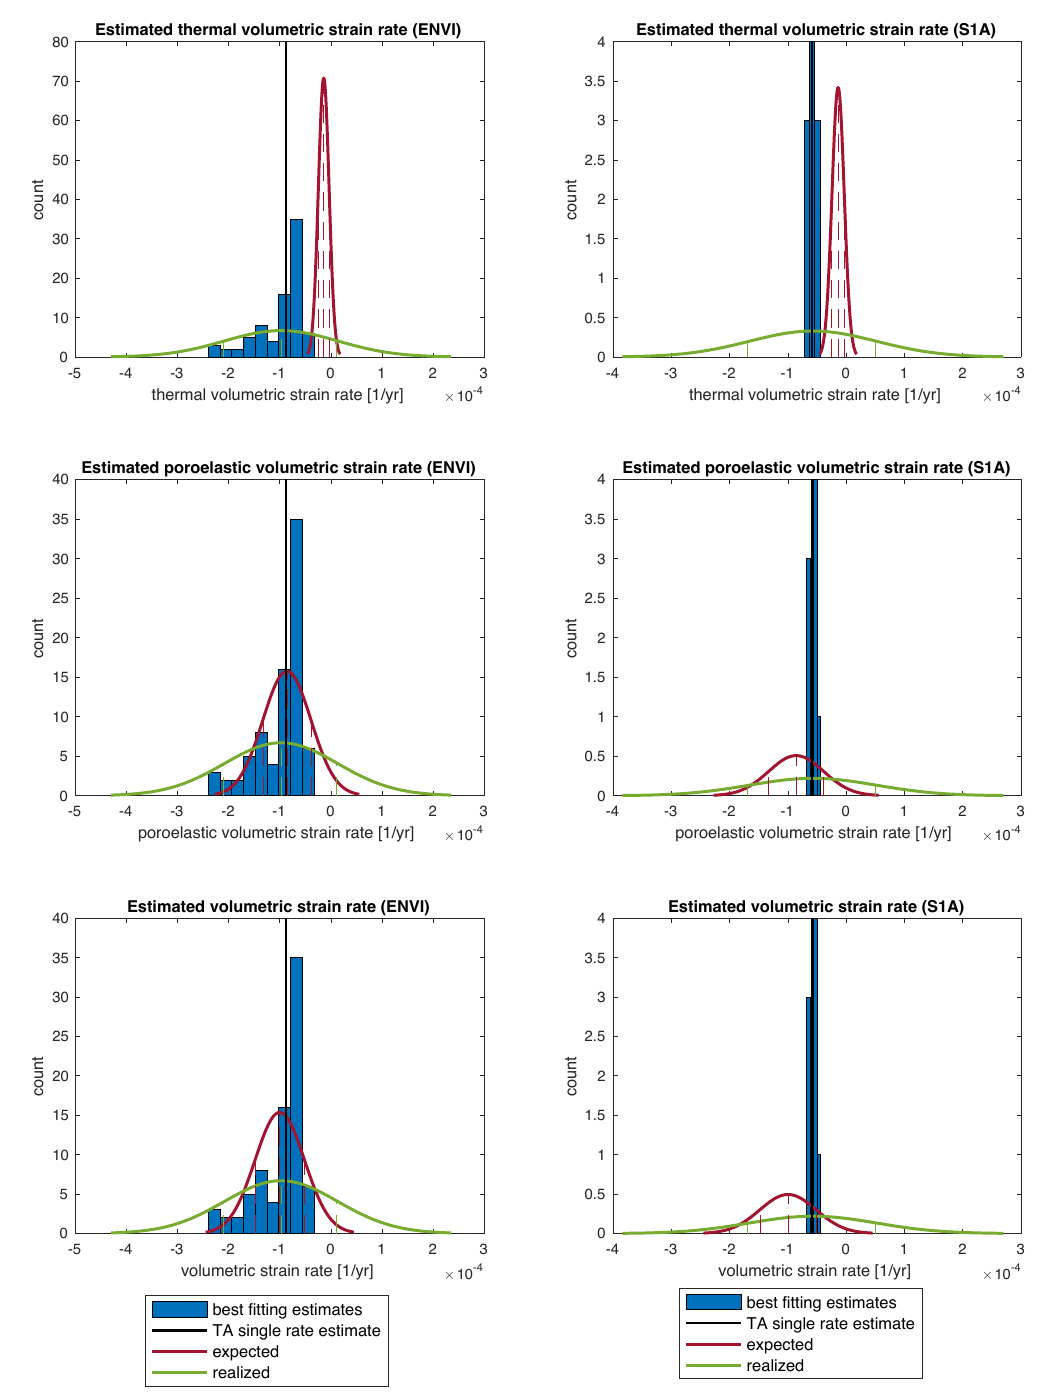
Figure 14. Histograms of best-fitting estimates of volumetric strain rates interpreted in terms of thermal contraction of the rock matrix (first row), a decrease in pore-fluid pressure (second row), and a linear combination of the two (third row) for Envisat pairs corresponding to the time interval from 2004 to mid-2010 (first column) and Sentinel-1A pairs corresponding to the time interval between 2014 and 2016 (second column). Overlain are 68% confidence intervals for reasonable values defined a priori (red) and realized values from deformation modeling (green). Also shown is the best fitting estimate of mean strain rate (black) found from temporal adjustment with a single rate temporal